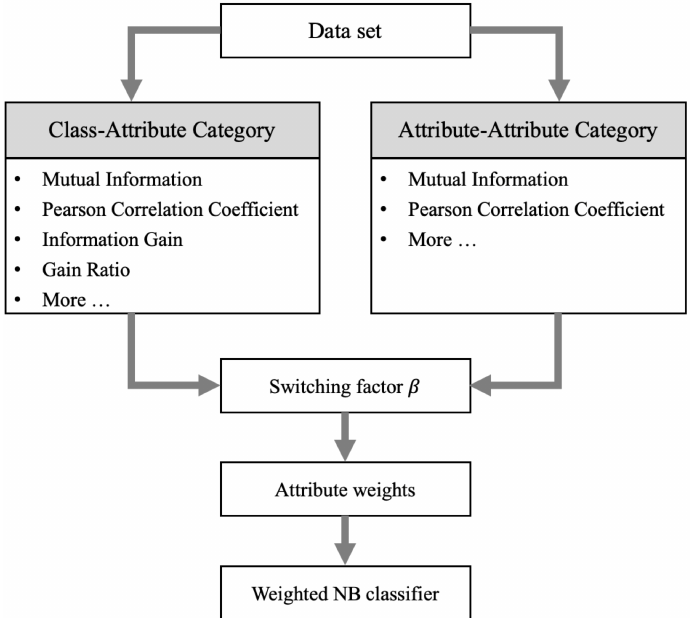
Figure 1. The general framework adaptive two-index fusion attribute-weighted